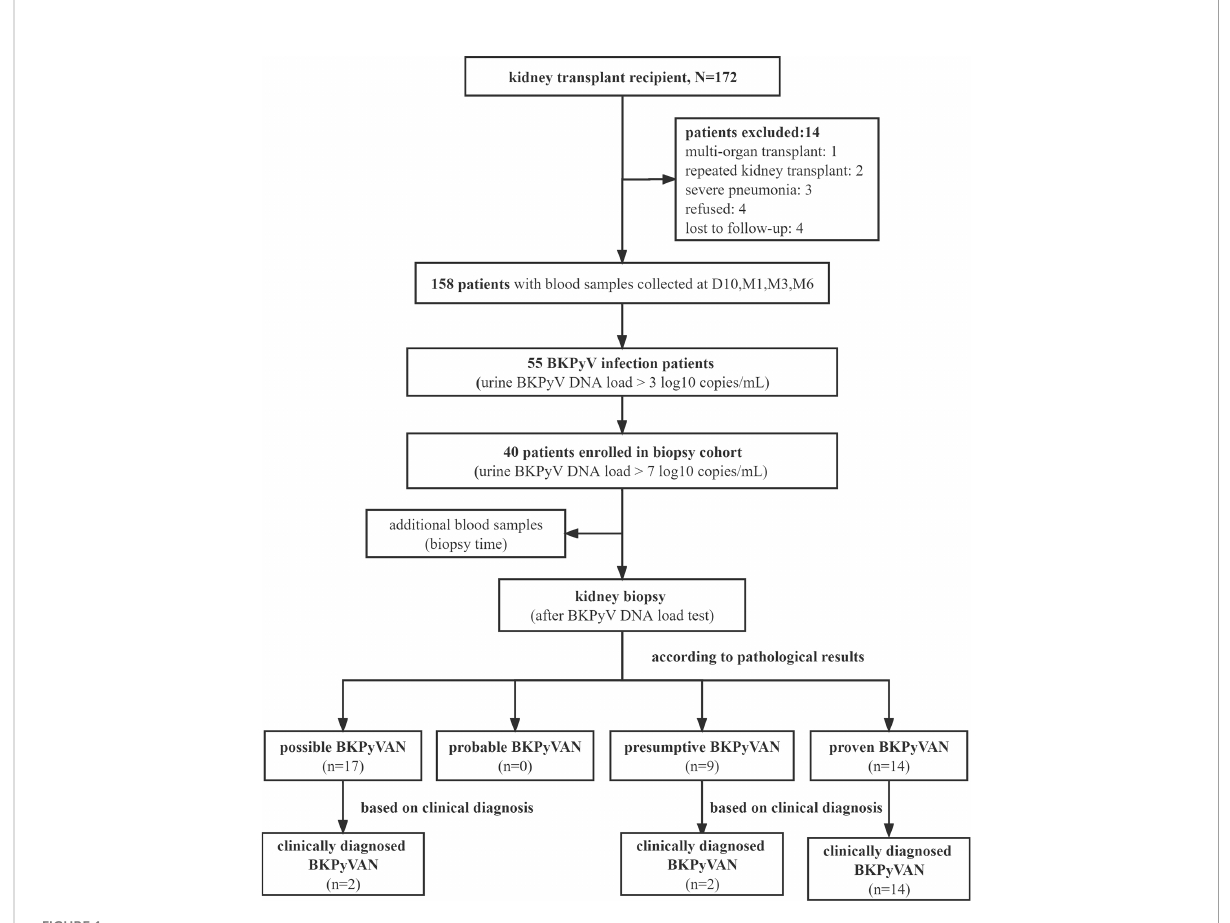
FIGURE 1 Consort diagram of patient fl ow through the